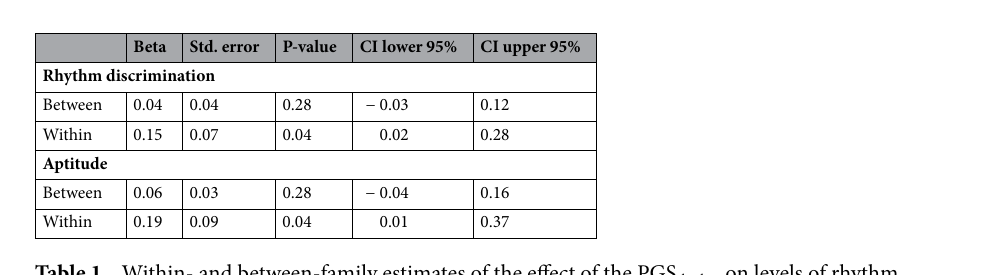
Table 1. Within- and between-family estimates of the effect of the PGS rhythm on levels of rhythm discrimination and musical aptitude in a sample of 243 complete dizygotic twin